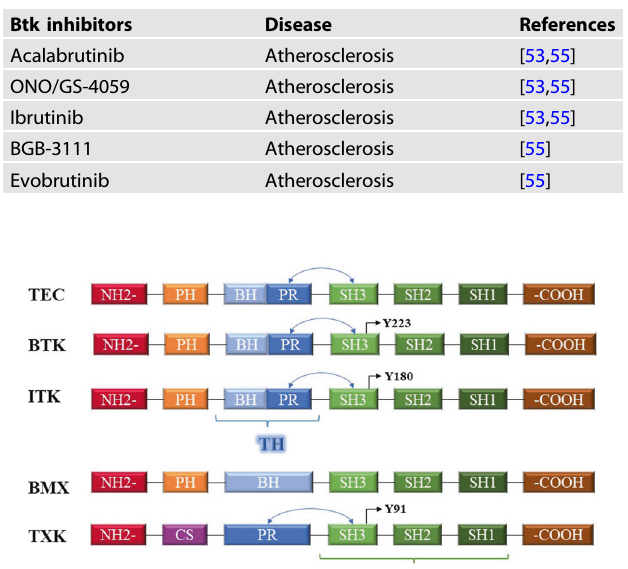
Table 3. So far, studies of Btk inhibitors related to cardiovascular disease.